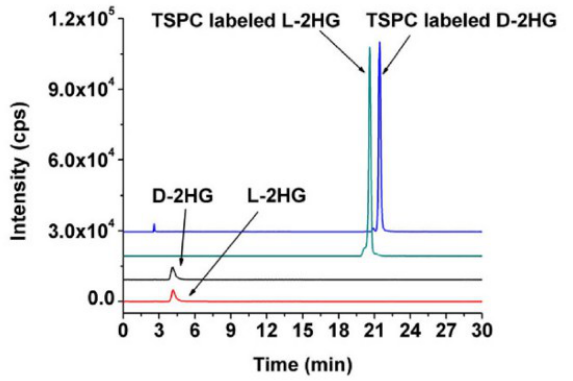
Figure 13. LC-MS / MS chromatograms of non-labeled and N -( p -toluenesulfonyl)-L-phenylalanyl Figure 13. LC-MS/MS chromatograms of non-labeled and N -( p -toluenesulfonyl)- L -phenylalanyl chloride (TSPC)-labeled ( R )- and ( S )-2-HG ( D and L , respectively). [66]. chloride (TSPC)-labeled ( R )- and ( S )-2-HG ( D and L , respectively). [78]. Table 5. Analytical methods for α-keto acids and 2-hydroxyglutaric acid (2-HG) in biological samples.